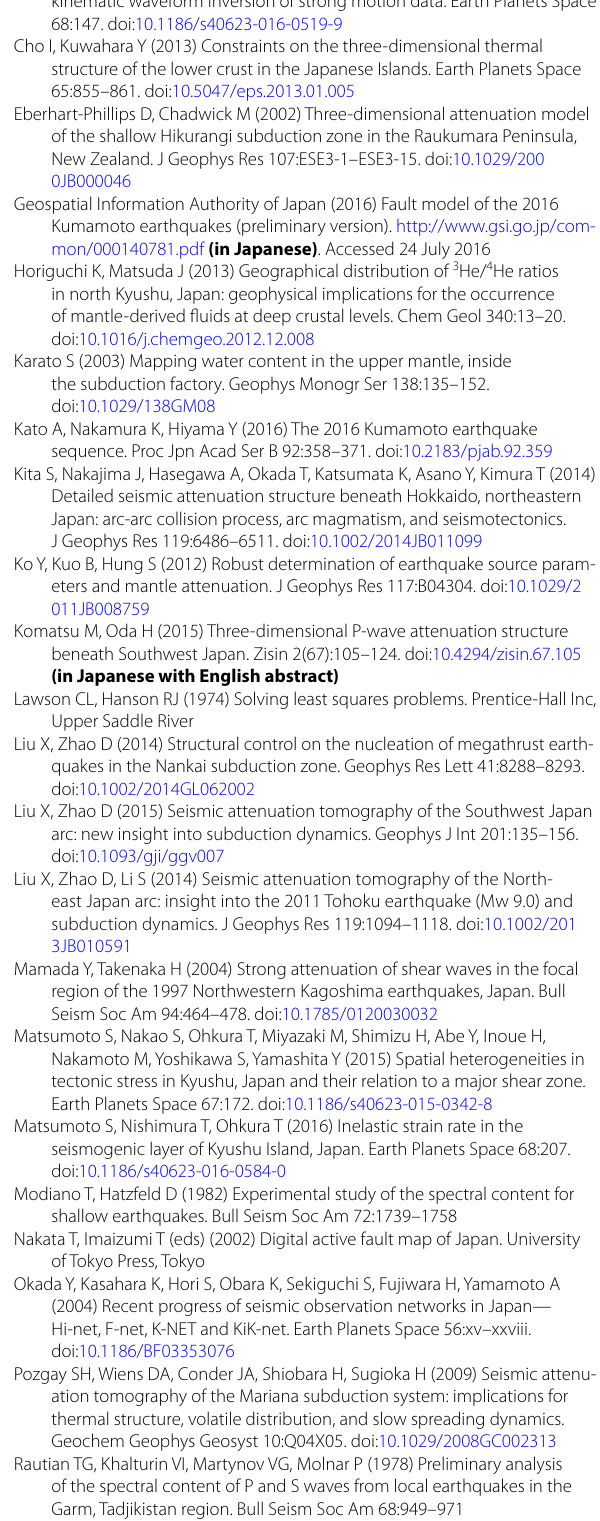
blue lines denote the Fourier amplitude spectra for signal and noise, respectively. The red line indicates the spectrum of the signal divided by the source spectrum, and the black dashed line denotes the regression line, which is given in Eq. (3) in the main text. Figure S3. Results of the 0.75. CRTs for a Q P-1 and b Q S-1 . The green lines indicate the location of R = Figure S4. Results of the RRTs for a Q P-1 and b Q S-1 . The left- and right- hand panels show the input and output structures, respectively. Figure S5. Lateral distribution of the estimated Q P-1 and Q S-1 in a the upper and b lower crust. The region shaded by gray shows low resolution, where the resolvability R of the CRTs is smaller than 0.75. Green , yellow , and sky blue stars indicate the epicenters of the largest foreshock ( M JMA 6.5), the mainshock ( M JMA 7.3), and the induced event ( M JMA 5.7), respectively. White stars show events of magnitude larger than M JMA 5.0 for one month follow- ing the largest foreshock. Black circles indicate the epicenters with 2.0